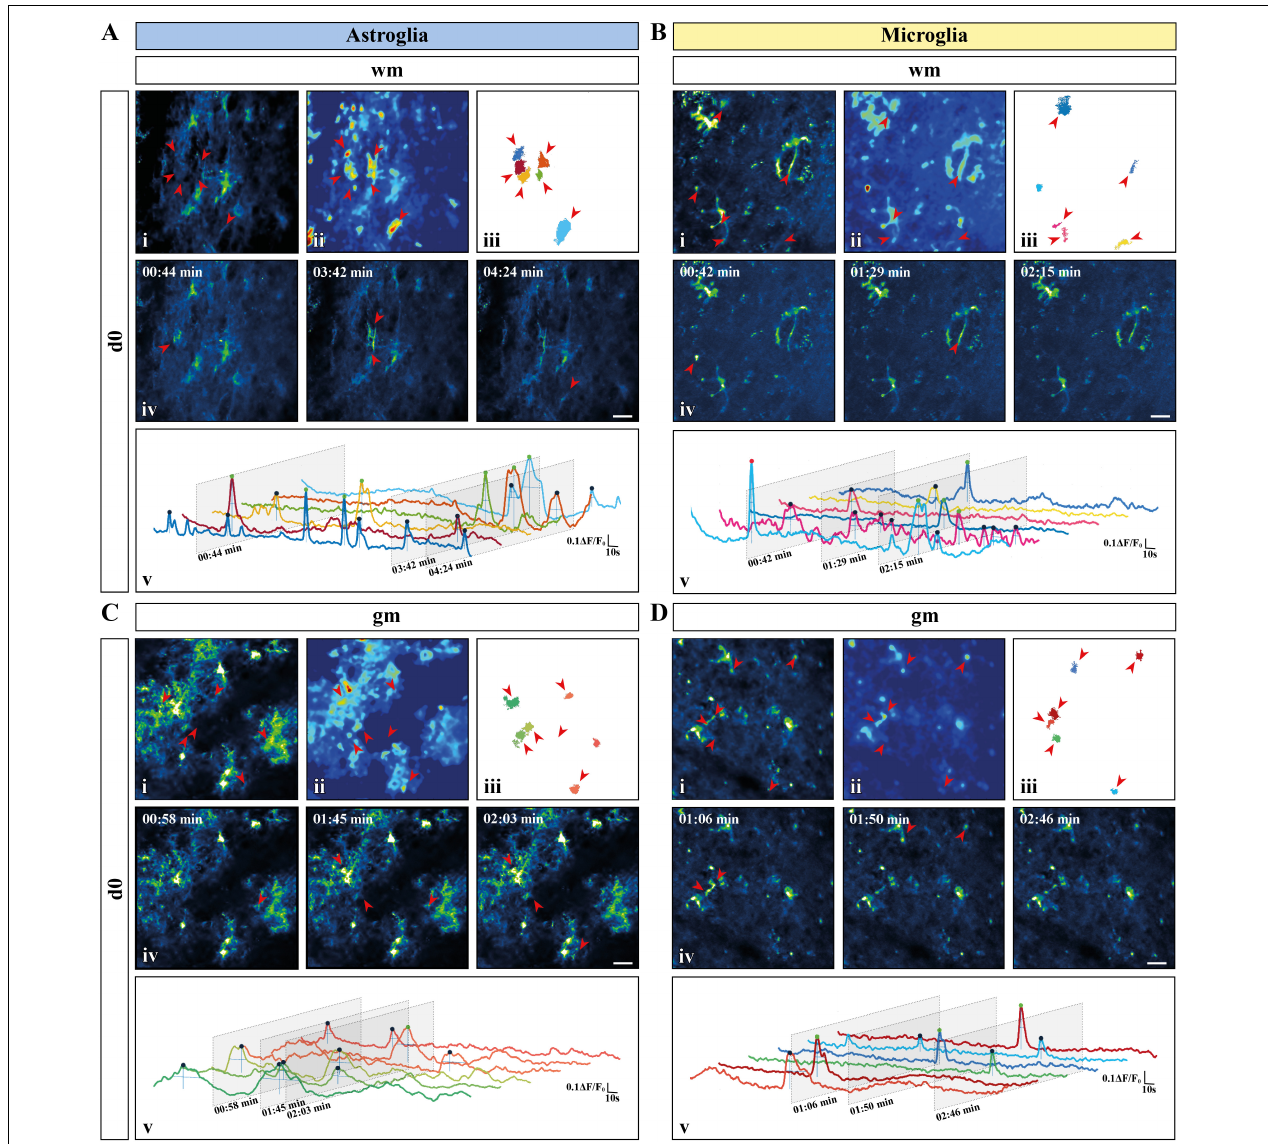
FIGURE 2 | Activity-based Ca 2 + signaling analysis for astroglia and microglia from acute preparations. (A–D) Representative Ca 2 + signaling analysis for astroglia [ (A) white matter ( wm ); (C) gray matter ( gm )] and microglia [ (B) wm ; (D) gm ] in acute slice preparations using the custom-made MATLAB-based software MSparkles. Maximum-intensity projection of the GCaMP3 signal for representative Fields of View [FOV; scale bar, 20 µ m; (i)] over the entire recording time (up to 5 min), absolute intensity projection (ii) and selected regions of activity [ROAs; (iii)] automatically detected using variations in absolute intensity. Red arrows indicate the locations of selected ROAs. Representative time frames from the selected recordings [scale bar, 20 µ m; (iv)] with red arrows indicating location of the selected ROAs if active in the displayed time frame. Normalized relative fluorescence intensity traces over time ( (cid:49) F/F 0 ) for the selected ROAs (v) with trace colors matching colors of the selected ROAs. Oblique sections indicate time points chosen for display. Automatically detected signals were pinpointed and color coded based on signal strength ( µ + σ ≤ (cid:49) F/F 0 ≤ µ + 2 σ , blue; µ + 2 σ < (cid:49) F/F 0 ≤ µ + 3 σ , green; (cid:49) F/F 0 > µ + 3 σ , red) calculated on the mean value ( µ ) and the corresponding standard deviation ( σ ) over all